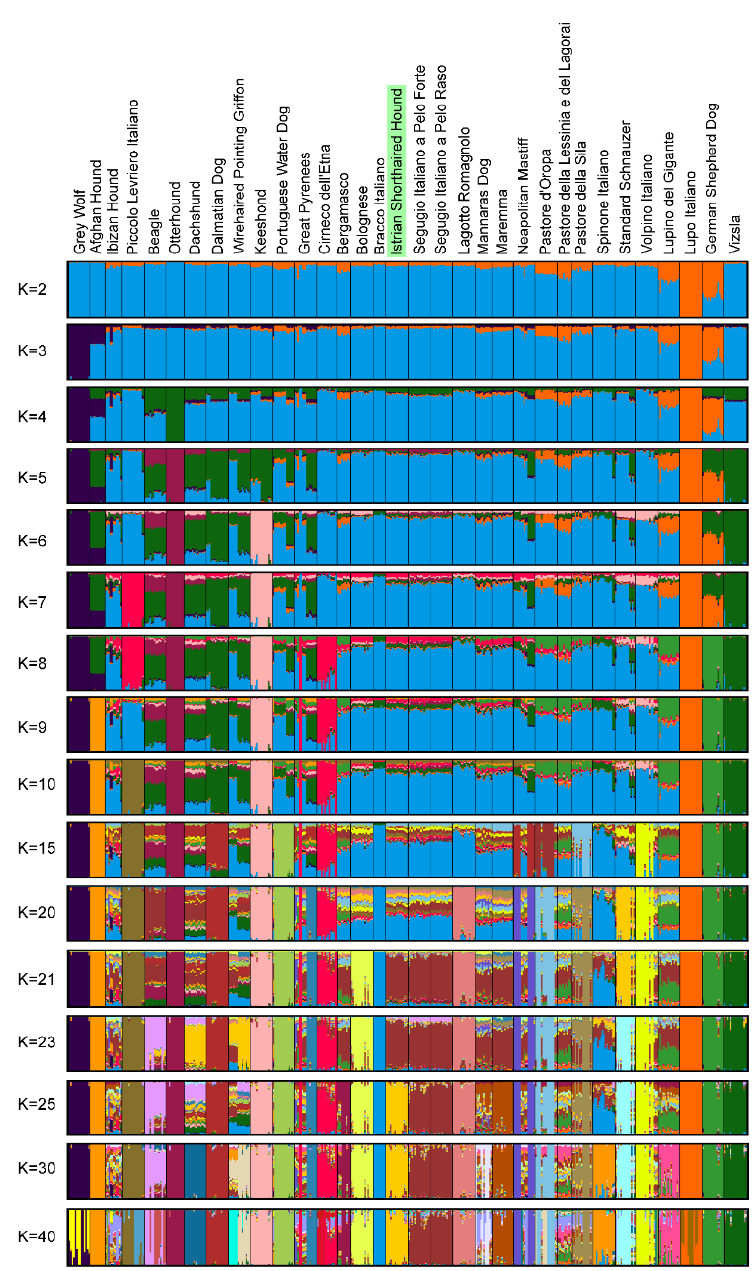
Figure 7. Population structure of Istrian shorthaired hound, 31 other dog breeds, and Grey wolf. Bayesian clustering performed with ADMIXTURE assuming K = 2 to K = 40. Each cluster is presented with a different color, and each individual is shown as a vertical bar representing the proportion of membership to a certain population.